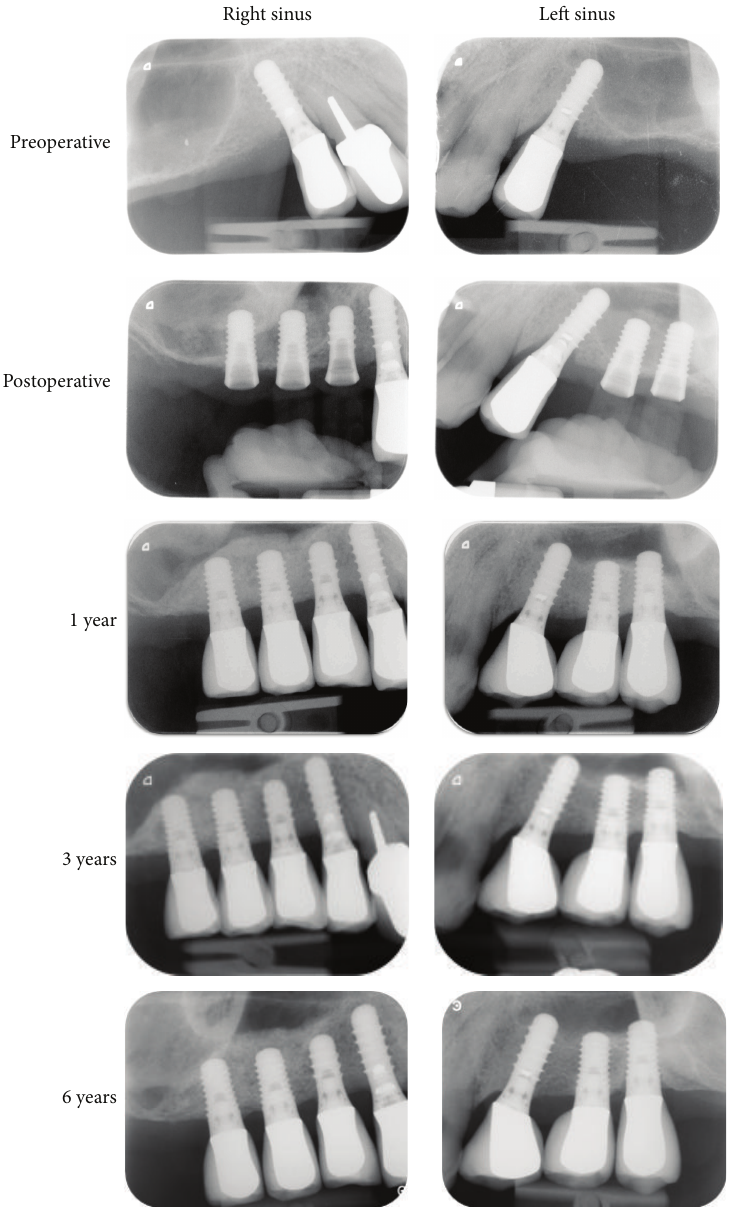
Figure 1: Periapical radiographs. The 8mm tapered implants were placed using the osteotome sinus floor elevation procedure with grafting material (right sinus) and without grafting material (left sinus). In all controls after surgery, implants were clinically stable. A radioopaque area corresponding to the augmented sinus floor was present around the implants placed without graft and around and above the implants placed with